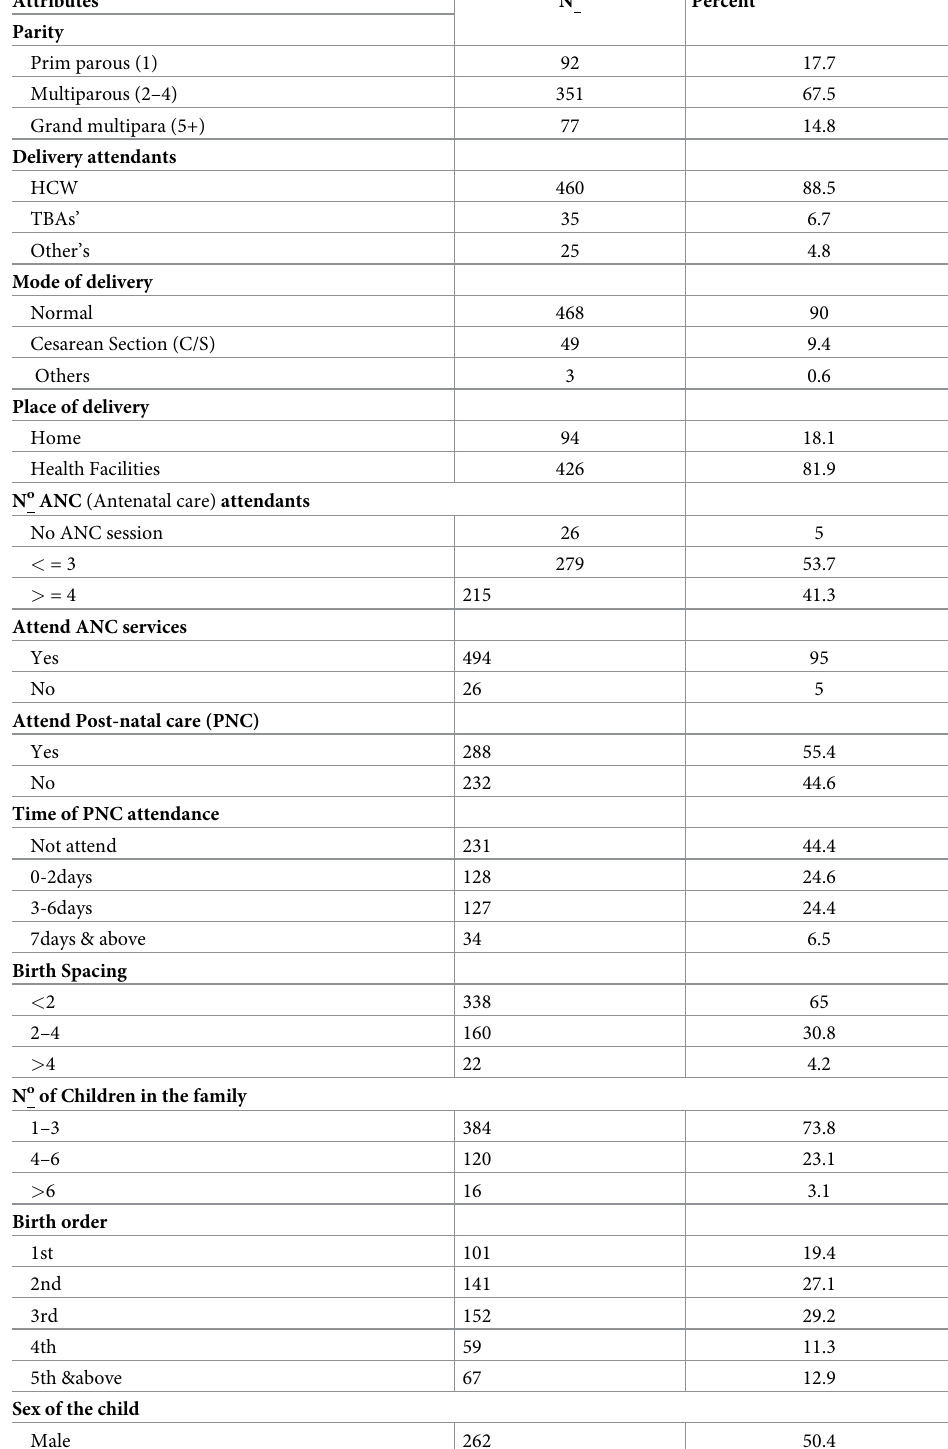
Table 2. Maternal obstetric related characteristics of mothers of children 6–23 month Shashamene town, Oro- mia-Ethiopia,